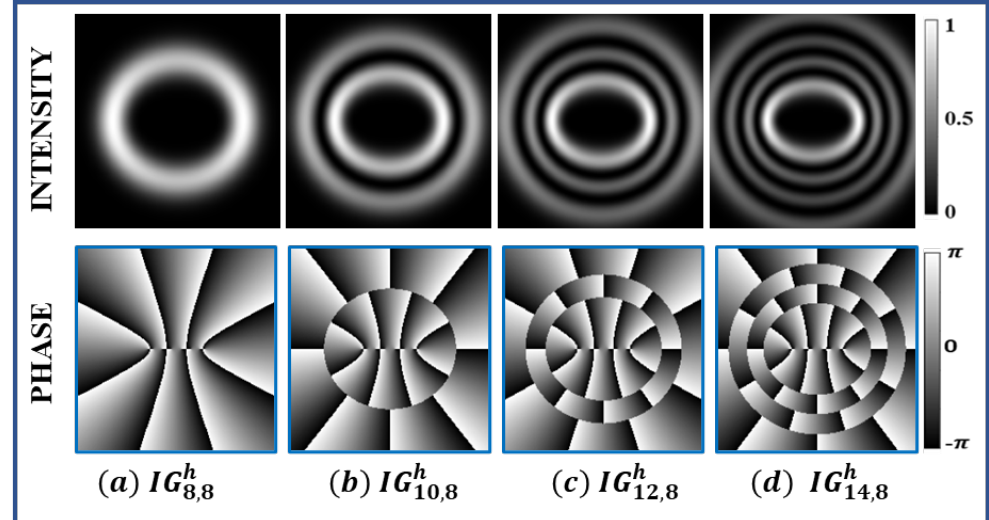
Figure 2. Intensity (first row) and phase profile (second row) profile of helical Ince − Gaussian beams ( a ) IG h , ( b ) IG h , ( c ) IG h , ( d ) IG h for (cid:101) = 8,8 10,8 12,8 14,8